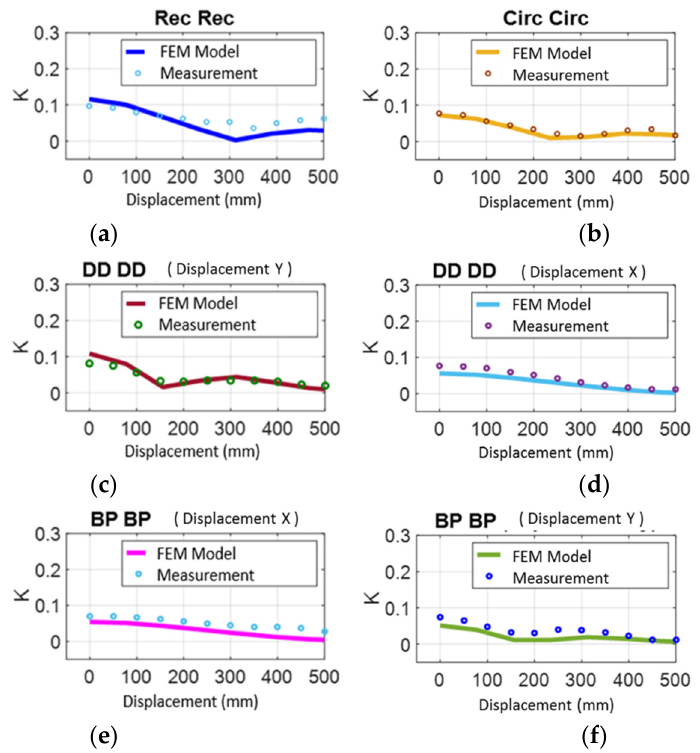
Figure 24. Comparison of the measured and simulated coupling coefficient for different topologies of coils for misaligned displacement with respect to the electric road. ( a ) rectangular; ( b ) circular; ( c ) DDX; ( d ) DDY; ( e ) BPX; ( f ) BPY.